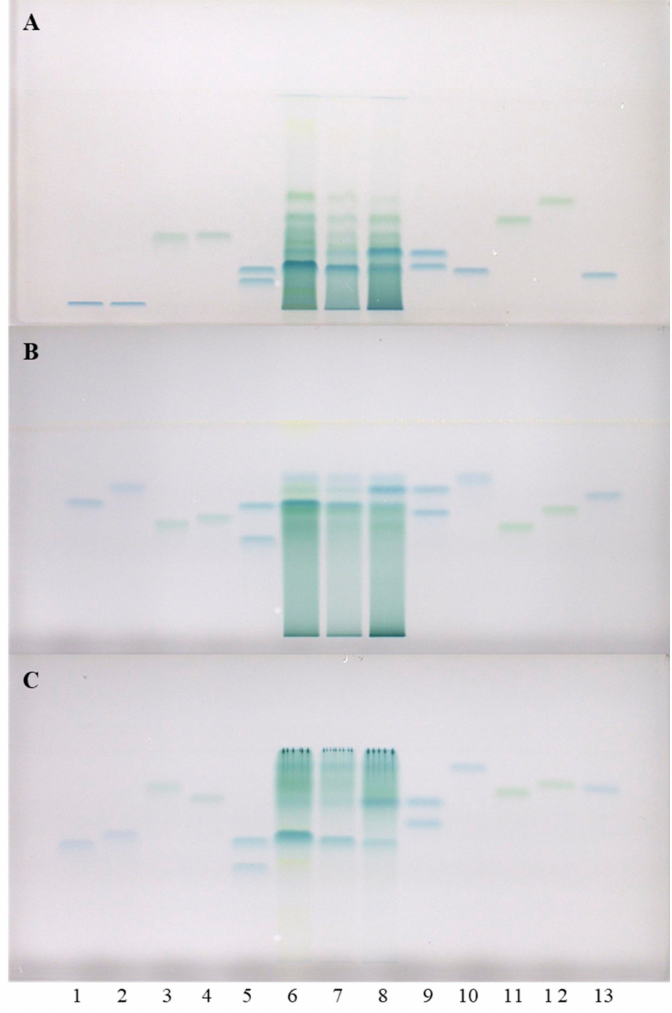
Figure 2. HPTLC chromatograms for the qualitative determination of flavan-3-ols and proantho- cyanidins in STSs from rhizomes (1 µ L, 50 mg/mL) of Japanese (track 6), Bohemian (track 7) and giant (track 8) knotweed based on standards. The HPTLC cellulose plates were developed with water ( A ), 1-propanol–water–acetic acid (4:2:1, v/v ) ( B ), 1-propanol–water–acetic acid (20:80:1, v/v ) ( C ), and documented at white light after derivatization with DMACA detection reagent. The ap plications of standards: ( − )-gallocatechin gallate (60 ng; track 1), ( − )-catechin gallate (60 ng; track 2), procyanidin C1 (150 ng; track 3), procyanidin B3 (100 ng; track 4), ( − )-epicatechin (50 ng; track 5, higher R F ), ( − )-epigallocatechin (60 ng; track 5, lower R F ), (+)-catechin (50 ng; track 9, higher R F ), ( − )-gallocatechin (60 ng; track 9, lower R F ), ( − )-epicatechin gallate (60 ng; track 10), procyanidin B1 (120 ng; track 11), procyanidin B2 (90 ng, track 12) ( − )-epigallocatechin gallate (60 ng; track